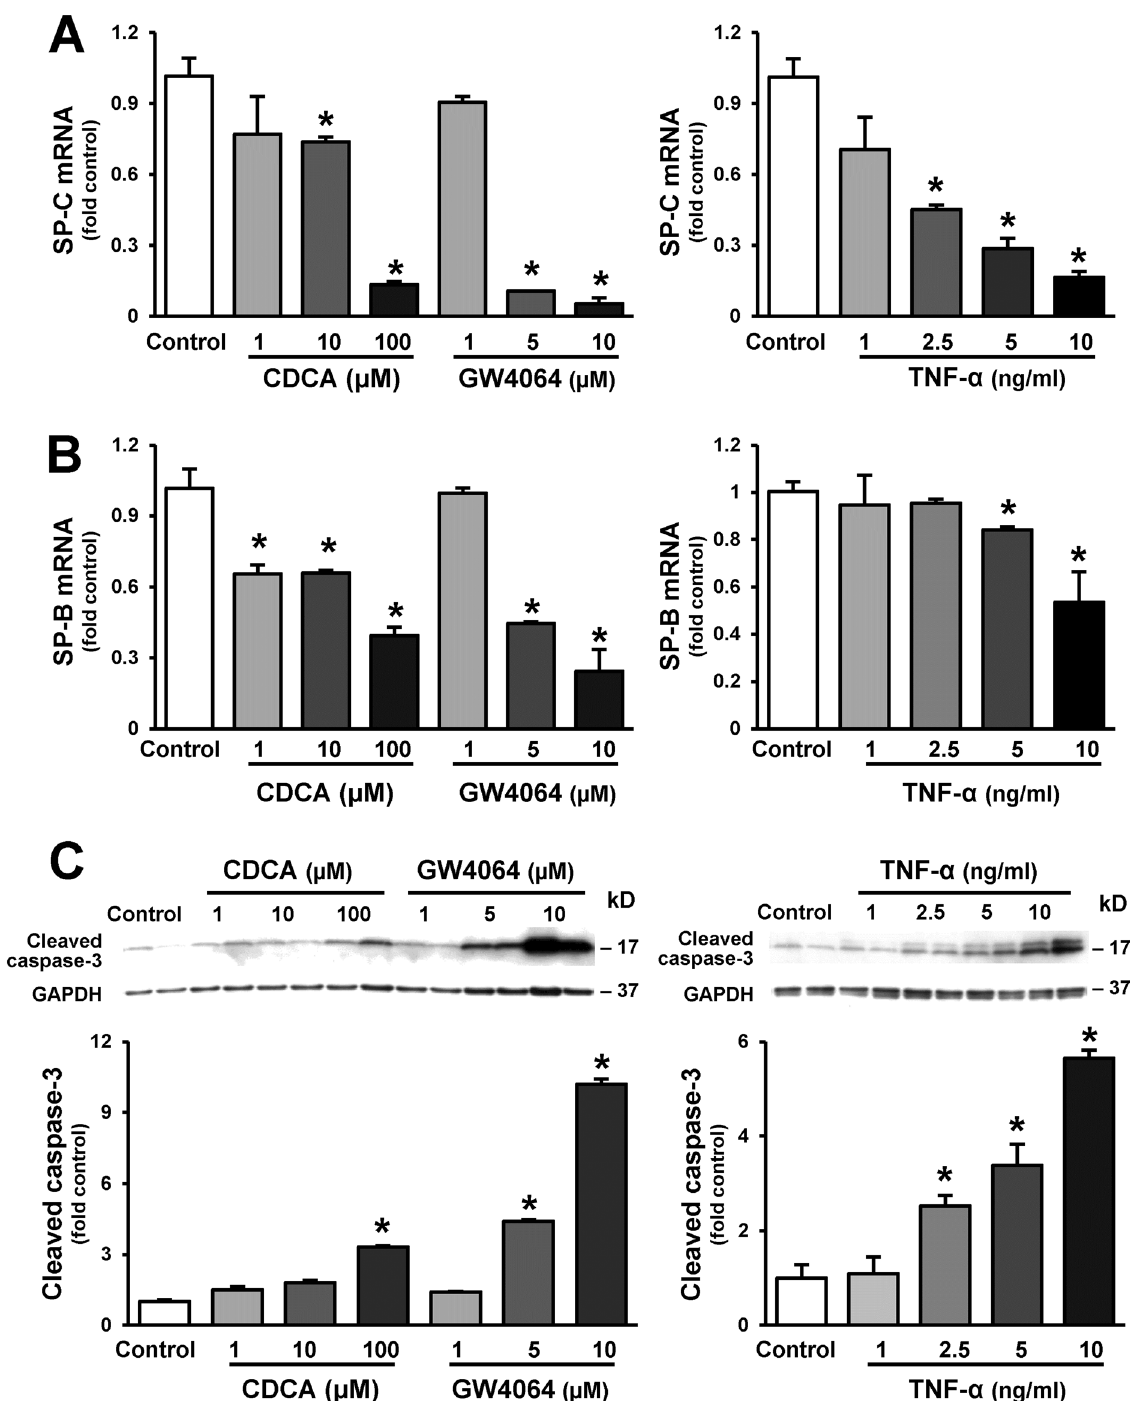
Figure 5. Effects of bile acids and TNF- a on SP-B and SP-C mRNA levels and cleaved caspase-3 expression. Mouse lung epithelial cells (MLE-12) were treated with a varying doses of chenodeoxycholic acid (CDCA, 1–100 m M, 24 hours), GW4064 (a FXR/bile acid nuclear receptor agonist, 1–10 m M, 24 hours) and TNF- a (1–10 ng/ml, 24 hours). The mRNA levels of SP-C and SP-B were measured by real-time RT-PCR. The protein levels of cleaved caspase-3 were assessed by western blots. Three independent experiments were performed. ( A ) Quantitation of SP-C mRNA levels. ( B ) Quantitation of SP- B mRNA levels. ( C ) Representative immunoblots and graphic summaries of cleaved caspase-3 protein levels. GAPDH was included as a loading